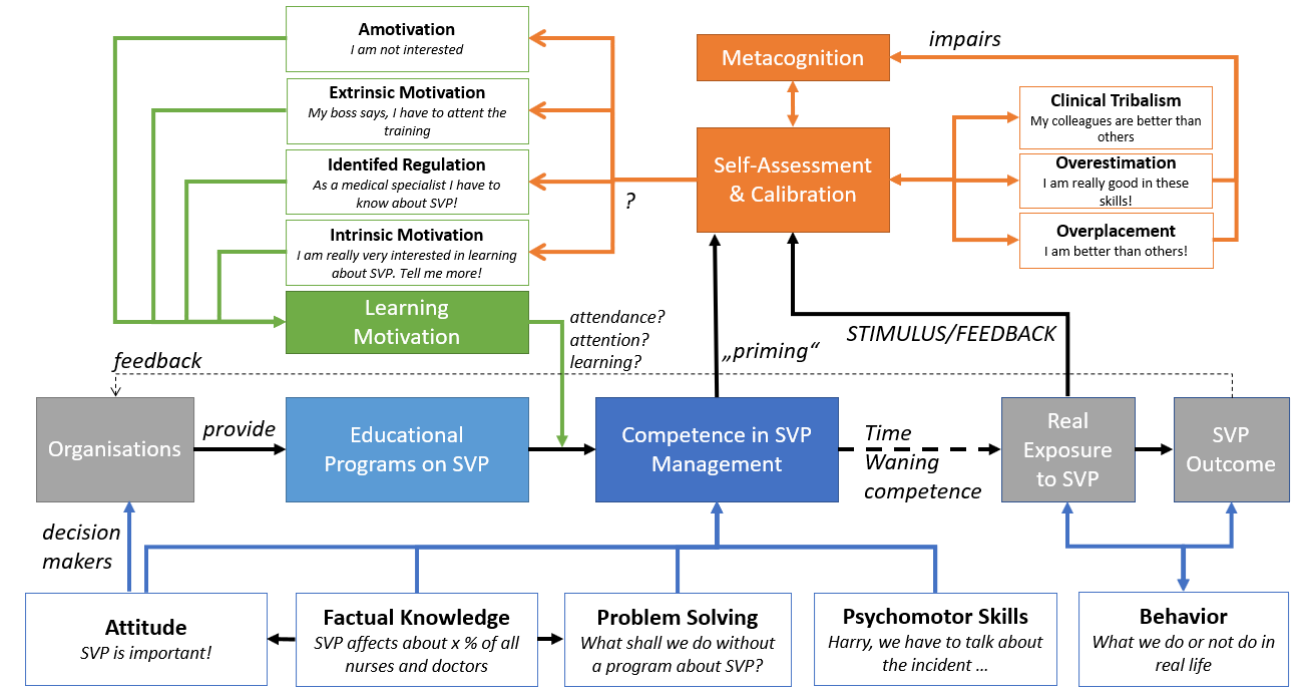
Figure 1. Theoretical Framework combining the different models of learning dimensions, learning motivation and overconfidence. Organisations with aware decision-makers towards SVP provide educational programs that communicate and teach attitudes, factual knowledge, problem-solving strategies and psychomotor skills [24]. Factual knowledge is important for creating attitudes and enabling problem-solving. In reality, these competencies (that may wane over time if not refreshed) are needed if an SVP situation occurs. The different behaviour of providers relying on competency may affect SVP outcome and provides modifying feedback to the health care worker. This (and maybe the first exposition to the topic, “priming”), as well as the complex issues of metacognition, may (dis)calibrate the person in his or her self-assessment on SVP competence and therefore alleviate or boost overconfidence effects [25,26] and logically the subjective need for learning. However, it remains unclear to what extent overconfidence effects contribute to learning motivation in SVP proficiency in detail (marked in the figure by